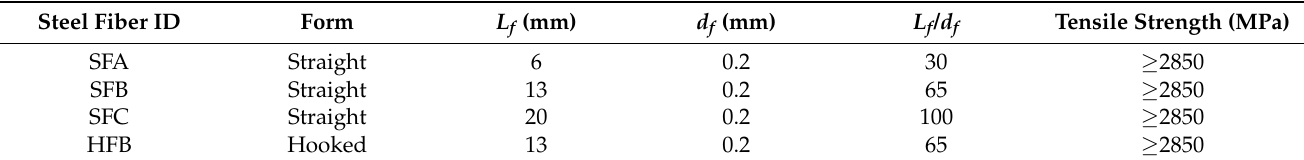
Table 4. Properties of high-strength steel fibers.